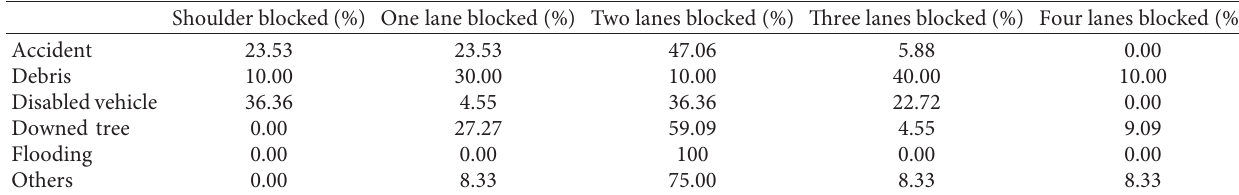
Table 6: Simulated shoulder/lane blockage caused by various incident